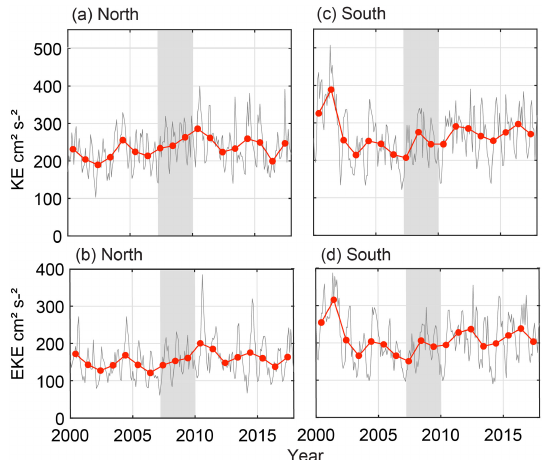
Figure 8. Monthly kinetic energy and eddy kinetic energy (grey) with yearly averages (January–December) (red). North and south divides are shown in Fig. 2a. (a) KE (cm 2 s − 2 ) in the north. (b) EKE (cm 2 s − 2 ) in the north. (c) KE (cm 2 s − 2 ) in the south. (d) EKE (cm 2 s 2 ) in the south. Grey shaded years (2008 and 2009) indicate the less-than-expected PI based on a priori relationships (Caputi et al.,